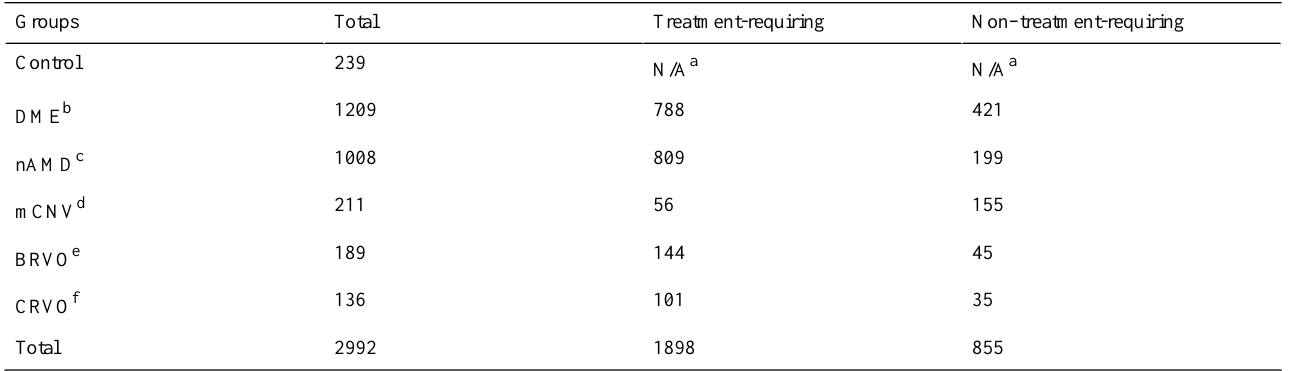
Table 1. Number of eyes included in the control and disease groups.